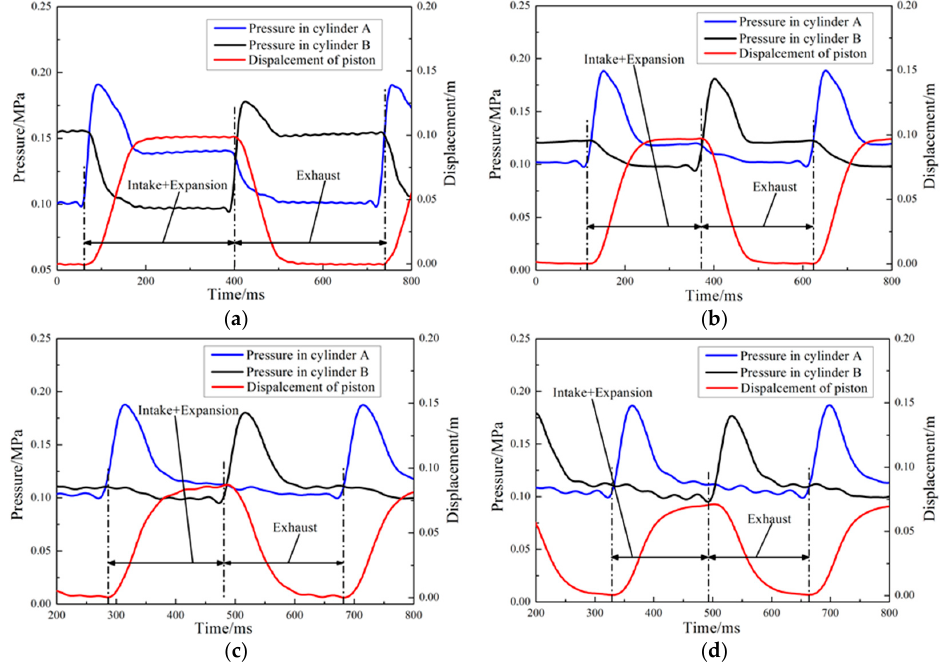
Figure 10. Variation of in ‐ cylinder pressure and piston displacement of the FPE A: ( a ) 1.5 Hz; ( b ) 2 Hz; ( c ) 2.5 Hz; ( d ) 3 Hz.